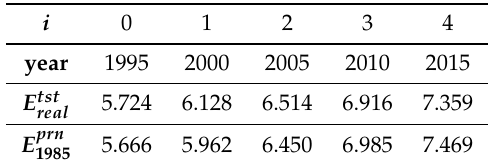
Table 2. Testing interval T tst .